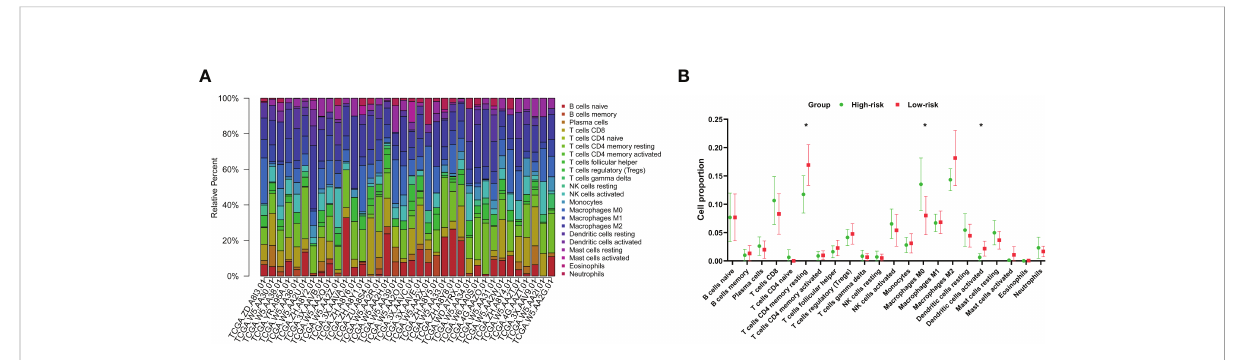
FIGURE 7 Characteristics of immunocytes in CCA. (A) CIBERSORT was used to calculate the relative percentages of 22 types of immunocytes for each CCA patient in the training cohort. (B) The mean relative proportions of the high- and low-risk groups. * P